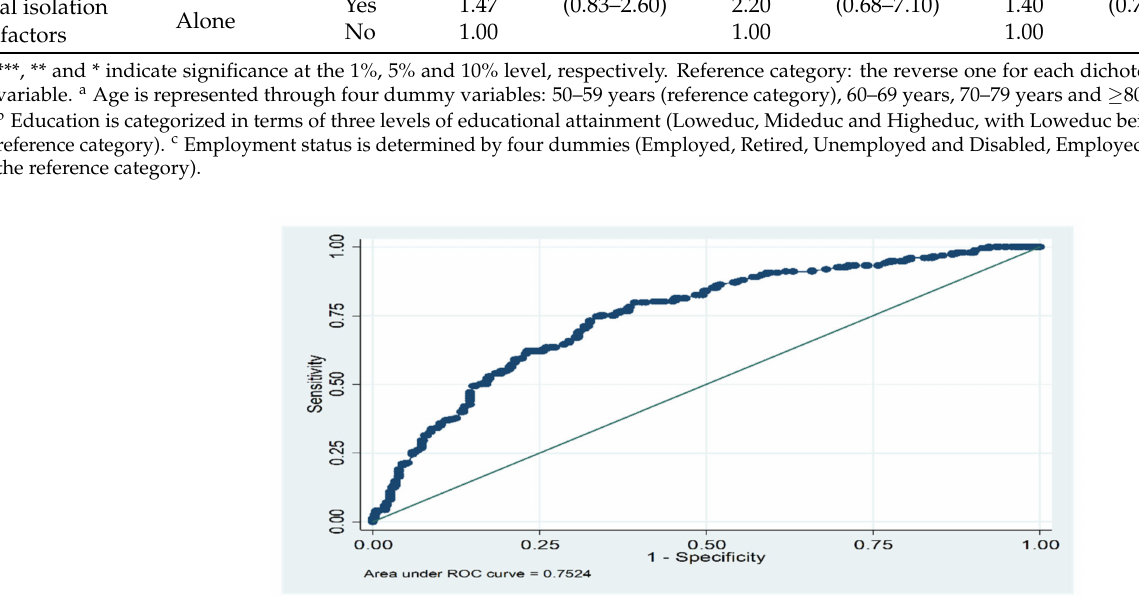
Figure 1. Receiver Operating Characteristic (ROC) analysis. Logistic model for casp_low_r ( n =